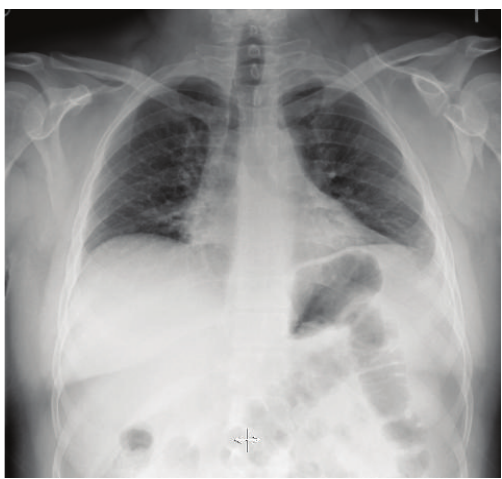
Figure 1: Anteroposterior chest radiograph demonstrating a left scapular fracture.